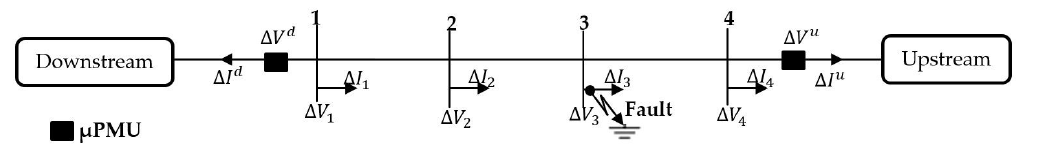
Figure 5. Example of a network based on the compensation theorem equivalent circuit with two µ